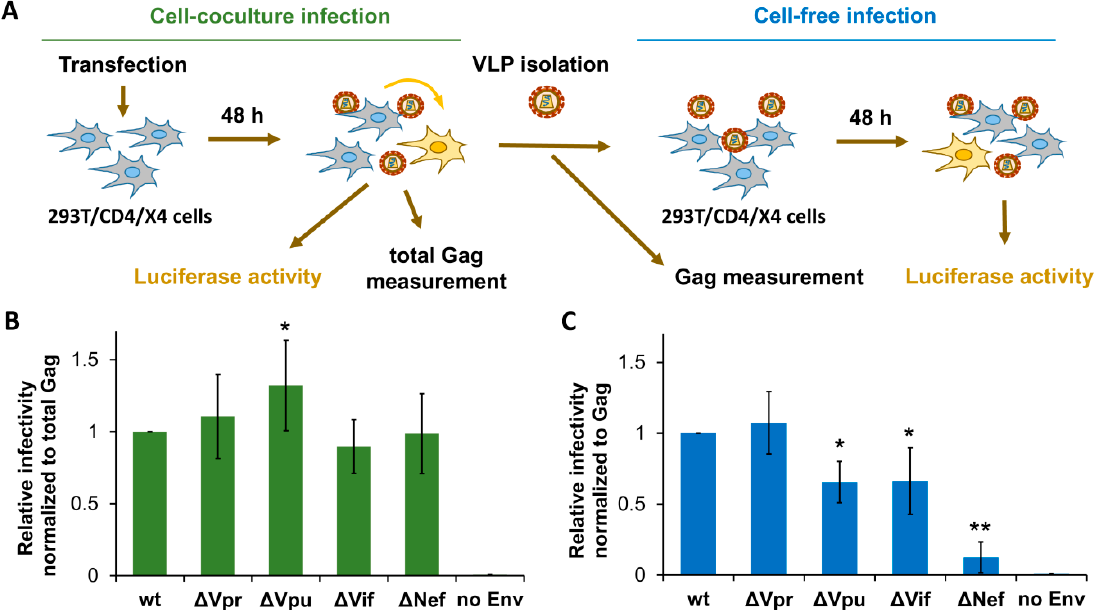
Figure 2. Effects of accessory gene inactivation on HIV-1 replication in HEK 293T/CD4/X4 cells. ( A ) Schematic representation of experiments designed to quantify and normalize HIV-1 infection in 293T/CD4/X4 cells. The levels of infection estimated by luciferase activity were normalized to the levels of Gag quantified by ELISA. The normalized level of infectivity obtained for wt HIV-1 was set at 1.0, and the infectivity levels for mutants were recalculated relative to that value. The levels of HIV-1 relative infectivity measured in 293T/CD4/X4 cell culture and cell-free infection tests are shown in ( B ) and ( C ), respectively. All data are representative of at least three independent experiments and shown as average values ± standard deviations. *, **, statistically different from the control (wt) by Student’s t -test at p < 0.05 and p < 0.01, respectively.